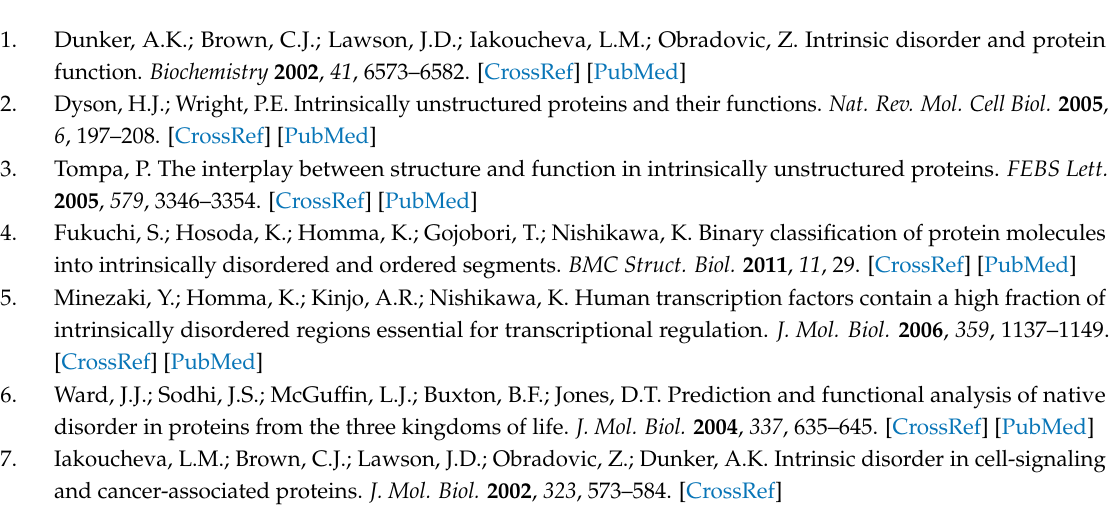
Figure S1: The brief outline of the procedure to obtain pProSs; Figure S2: A structural example of a functional fragment found in an experimentally verified IDR; Figure S3: The non-membrane organelles found in the annotations of the disease-related proteins; Table S1: pProSs frequently found in the disease-related proteins; Table S2: The list of disease involving p53; Table S3: The disease associated mutation sites found in the predicted IDRs; Table S4: The numbers of annotations found on IDRs in the other model organisms; Table S5: The redundancy of pProS by the disease categories; Table S6: Proteins involved in multiple diseases; Table S7: The list of pProSs found in this